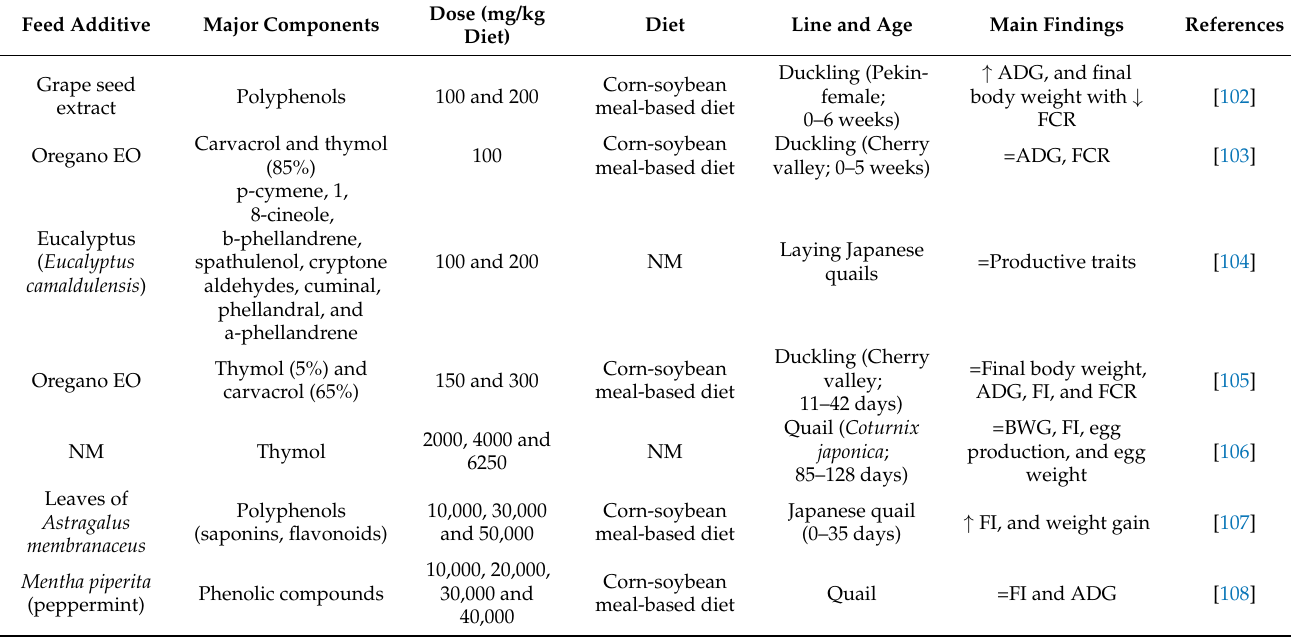
Table 3. Effects of dietary supplementation of PFAs on growth performance of other birds under non-challenging conditions. Feed